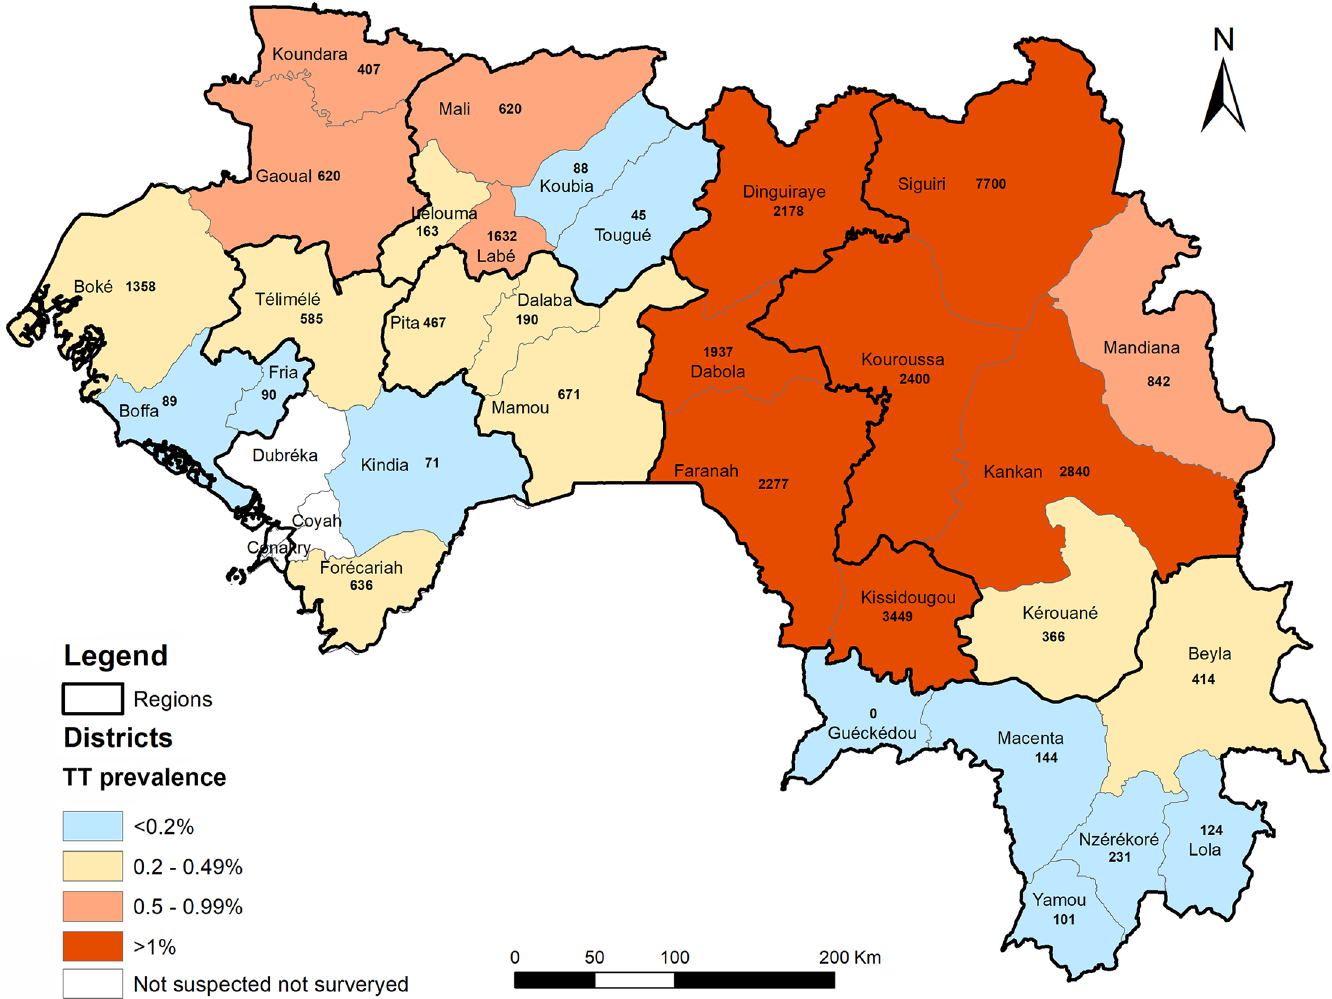
Fig 2. Health district TT prevalence categories and cases in Guinea. Numeric numbers represent the estimated number of TT cases in population aged (cid:21) 15 years in each HD. Figure was created for this publication using shapefiles from the GADM database (www.gadm.org), version 2.8, November 2015 and ArcGIS 10.4.1 for Desktop (ESRI, Redlands,